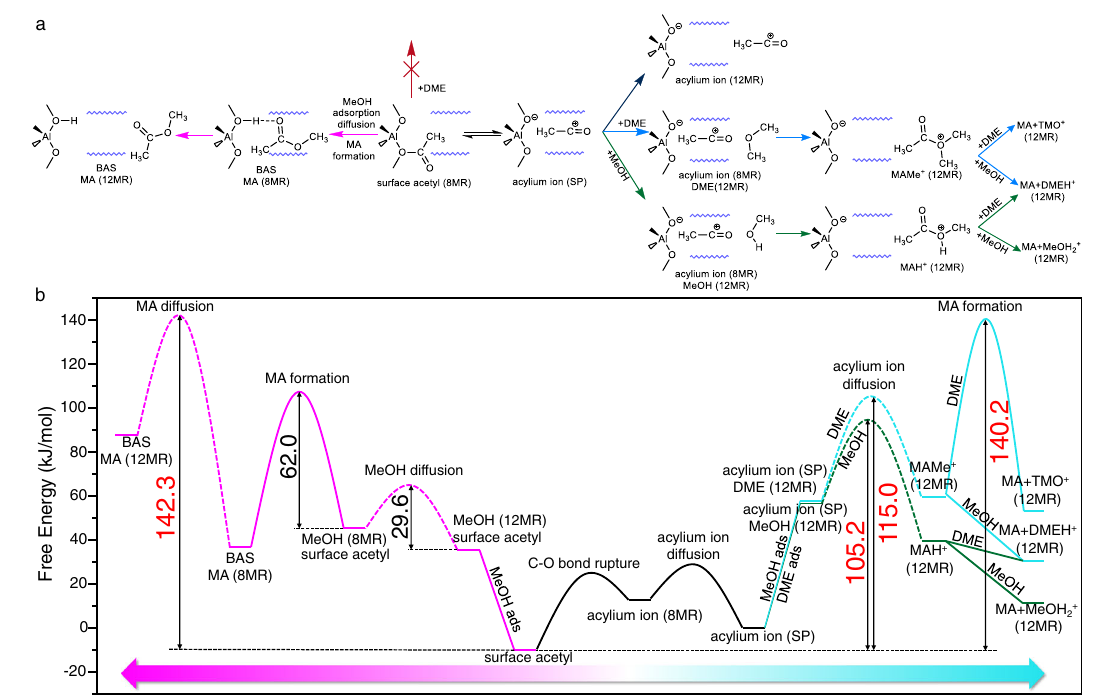
Fig. 3 | MA formation based on the acylium ion in the side pocket (SP) and surface acetyl in the 8MR channel. a reaction pathways, and b free energy pro fi le. The dotted lines in b indicate the diffusion process; the values in black are the free energy barriers; the values in pink are the maximum free energy spans.